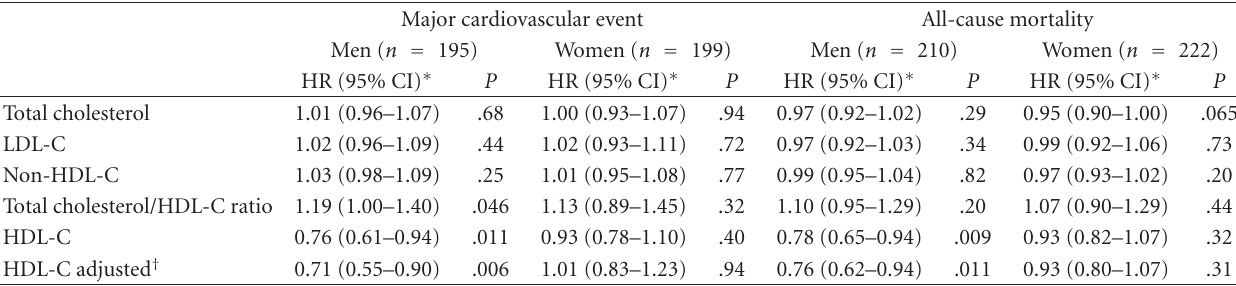
Table 2: Hazard ratios for major cardiovascular event defined as hospitalization or death caused by myocardial infarction, stroke, or ruptured aortic aneurysm or all-cause mortality according to serum levels of cholesterol and its subfractions.